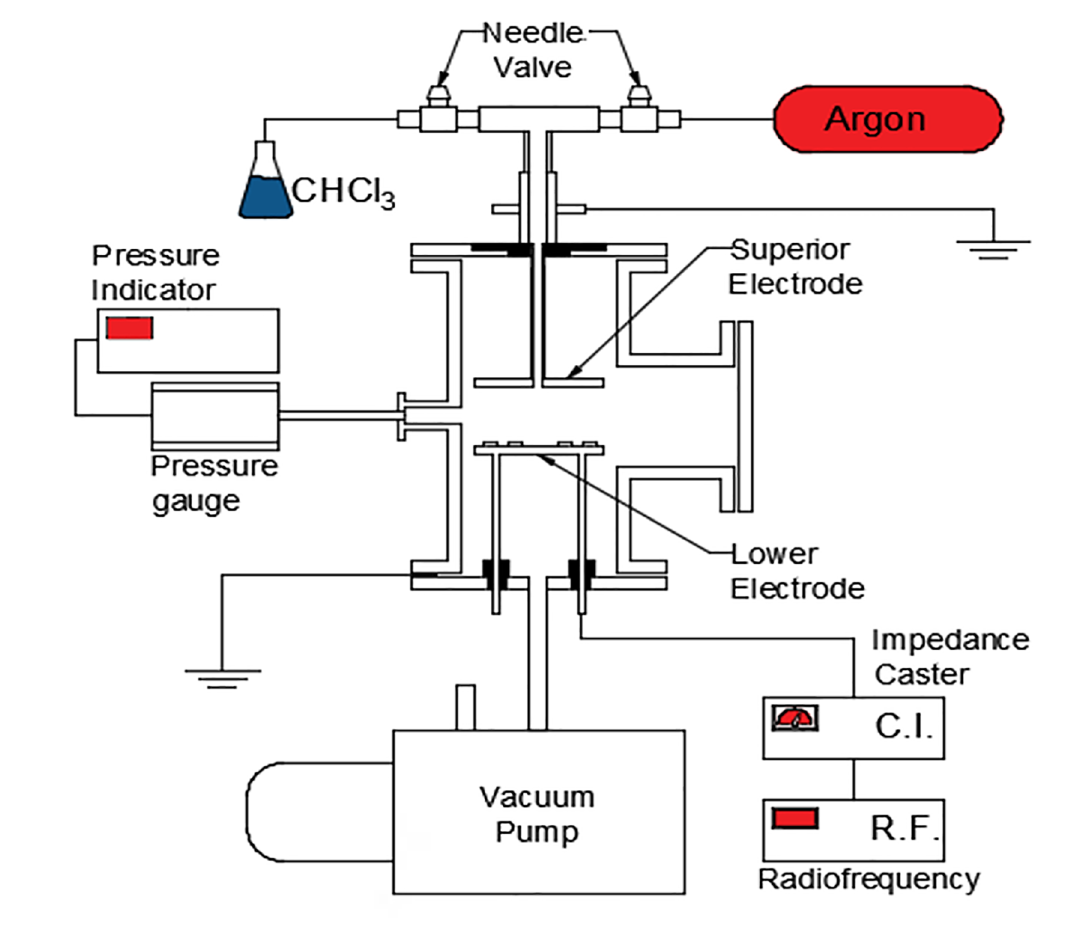
Figure 1. The plasma treatment system.